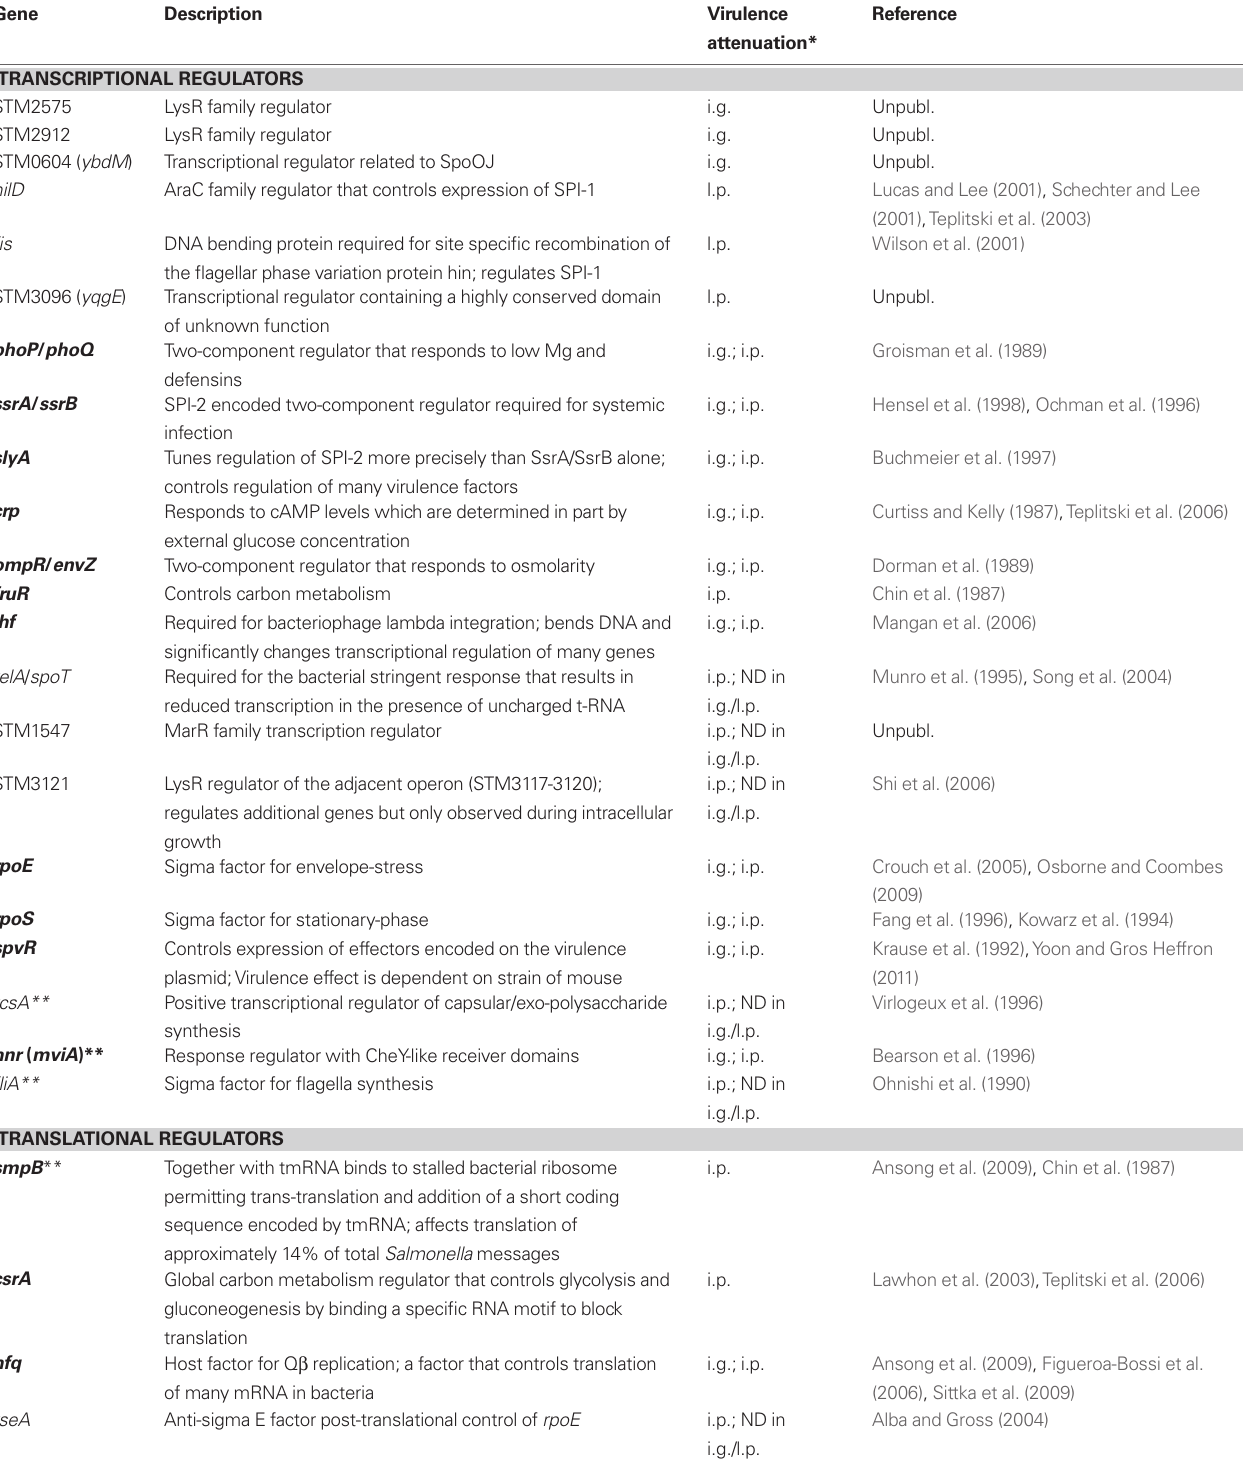
Table 1 | Regulators involved in virulence